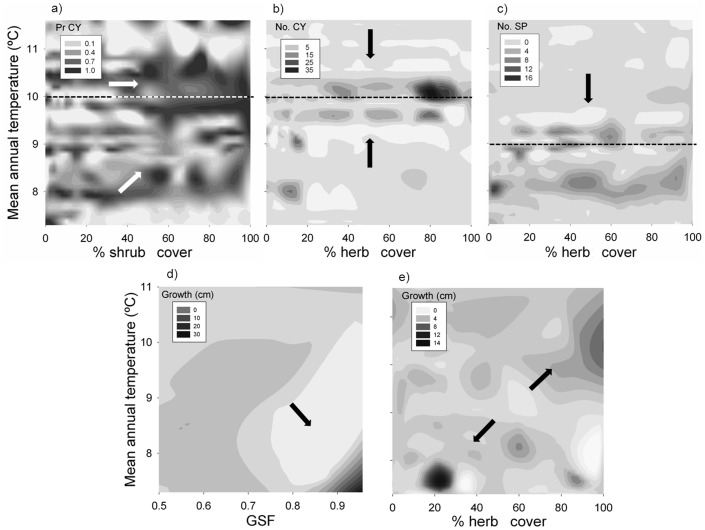
Significant interactions among mean annual temperature and: a) cover of shrubs affecting the probability of current-year seedlings' presence (Pr CY); b) herb cover affecting the abundance of seedlings (No. CY); c) herbs over the abundance of saplings (No. SP); d) GSF affecting mean growth of SP; and e) herbs on mean growth of saplings.Dotted line shows the mean annual temperature at which the number of CY (a, b) and SP (c) were more frequent, respectively.